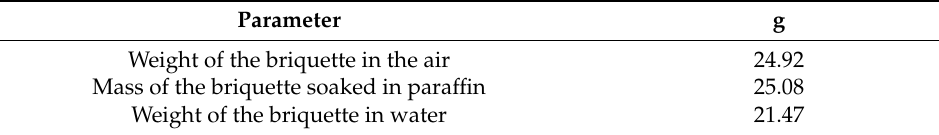
Table 3. The weight of the briquette used to determine the density.